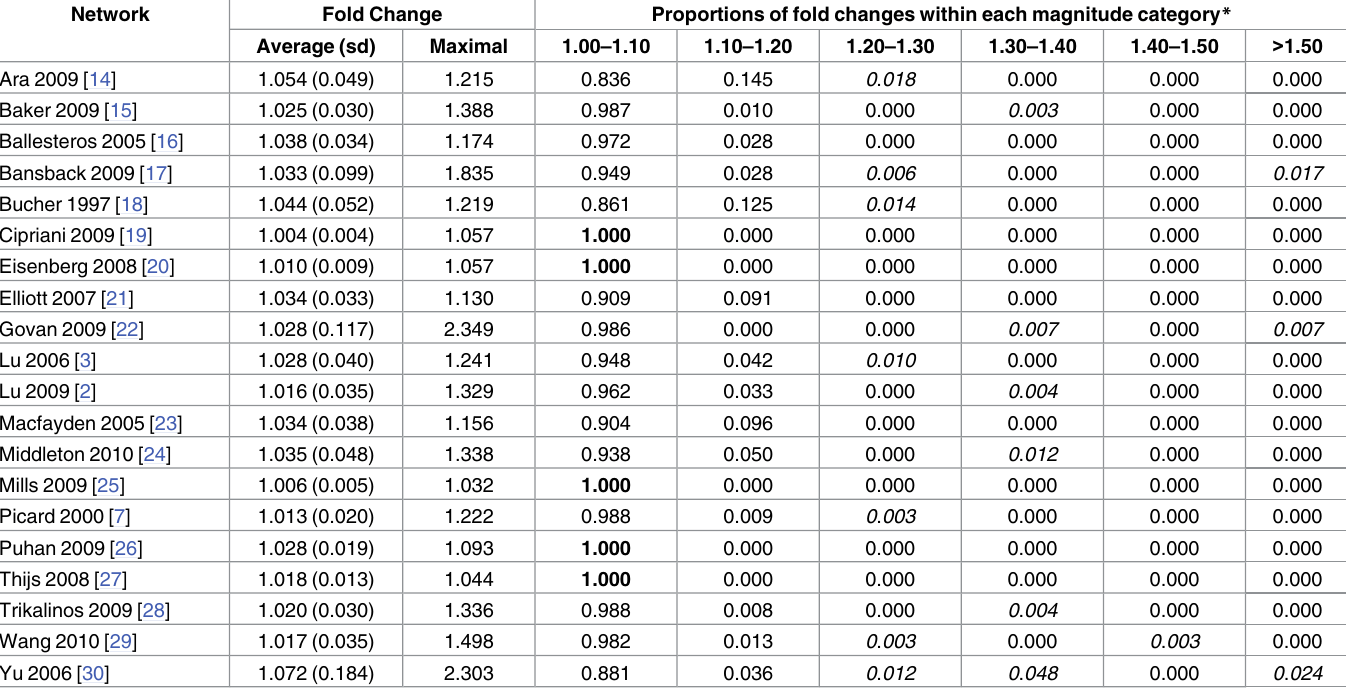
Table 2. Summaryof fold changes in terms of estimated event rates using the AB approach. Network Fold Change Proportions of fold changes within each magnitude category